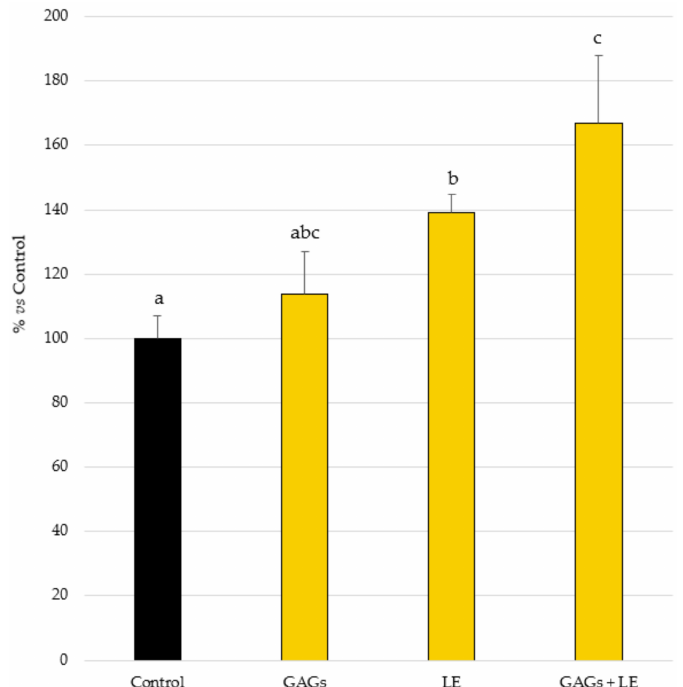
Figure 1. β -defensin 2 (hBD-2) production by normal human epidermal keratinocytes treated with cytokine mix (OSM + IL-17 + TNF- α at 5 ng/mL each) adding the test compounds (LE and GAGs), alone or in combination, at 0.02 mg/mL each, or not (Control). Mean ± SEM values of % of basal control are shown. Different letters indicate statistically significant